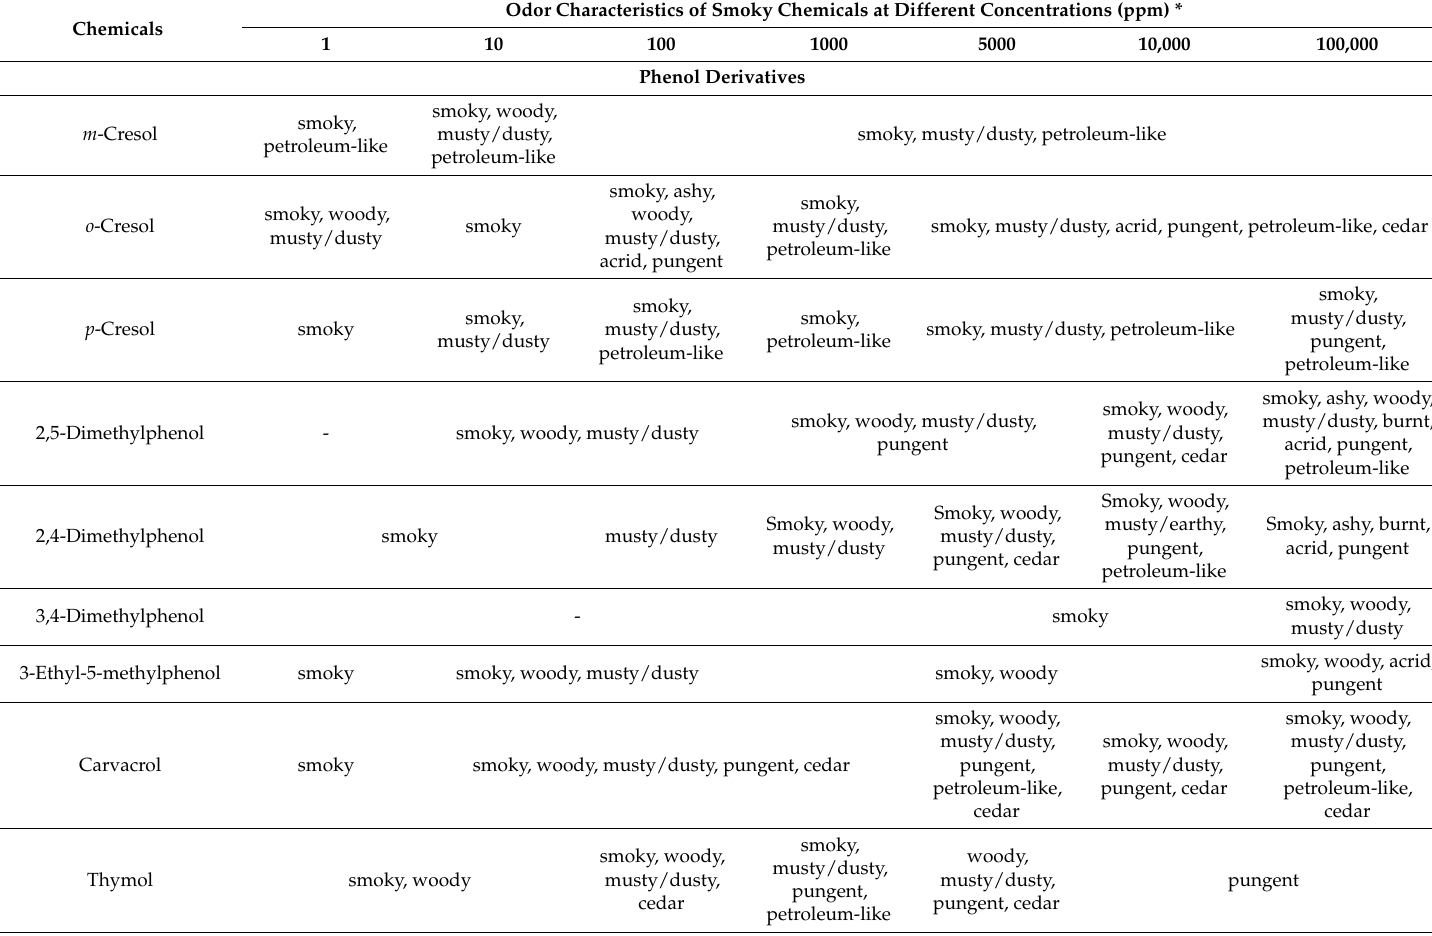
Table 2. Odor attributes of chemicals exhibiting smoky characteristics at different